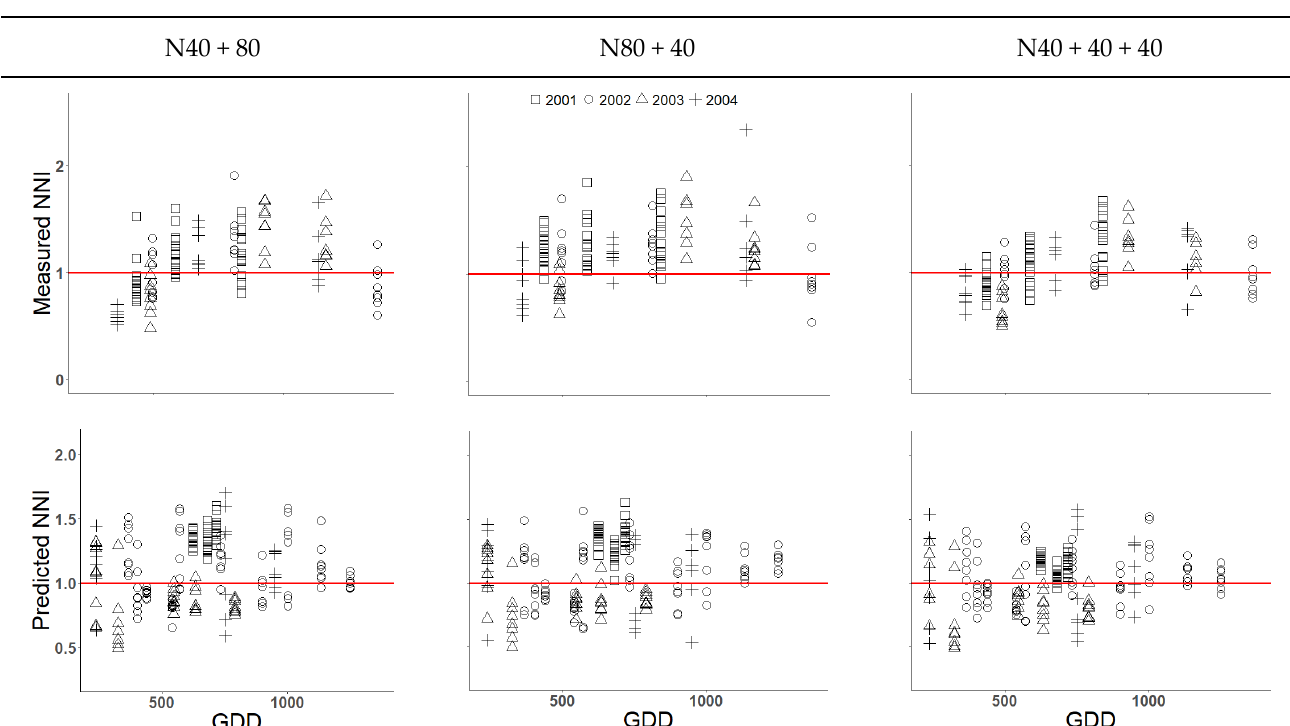
Figure 5. Measured and predicted NNI for 2001, 2002, 2003, 2004, per GDD for each split N treatment. A red horizontal line is drawn at NNI = 1.